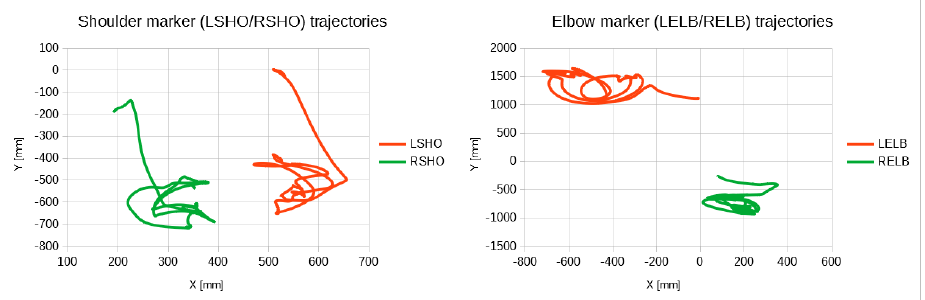
Figure 6. Trajectories for upper body parts for the second sequence.